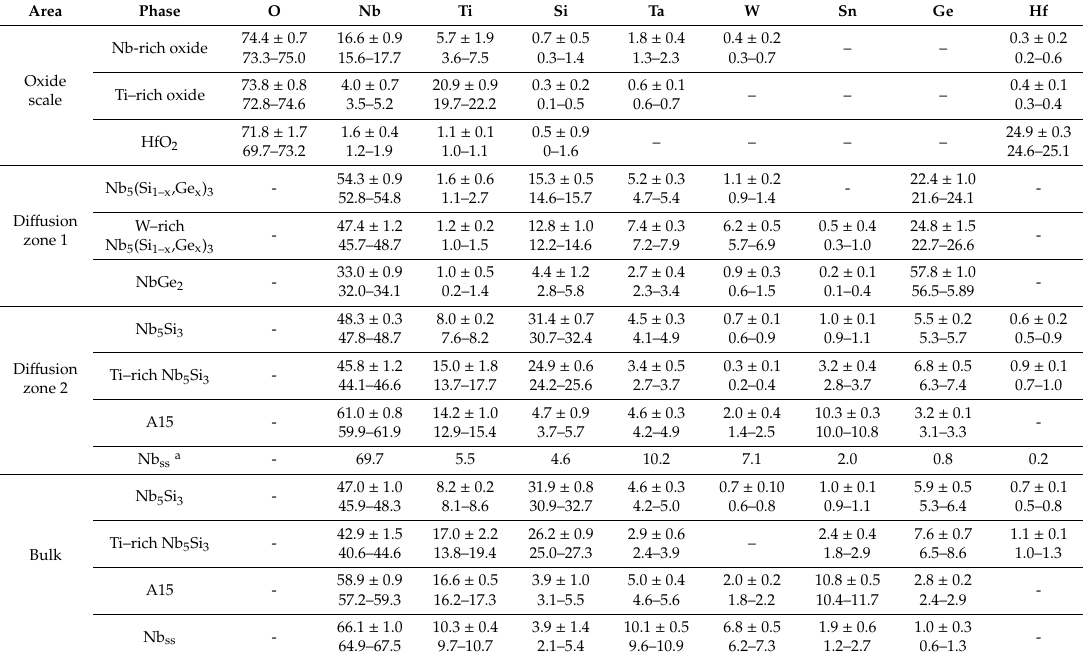
Table 5. Analysis data (at.%) of phases in the alloy JZ2 after isothermal oxidation at 1200 ◦ C for 100 h. Area Phase O